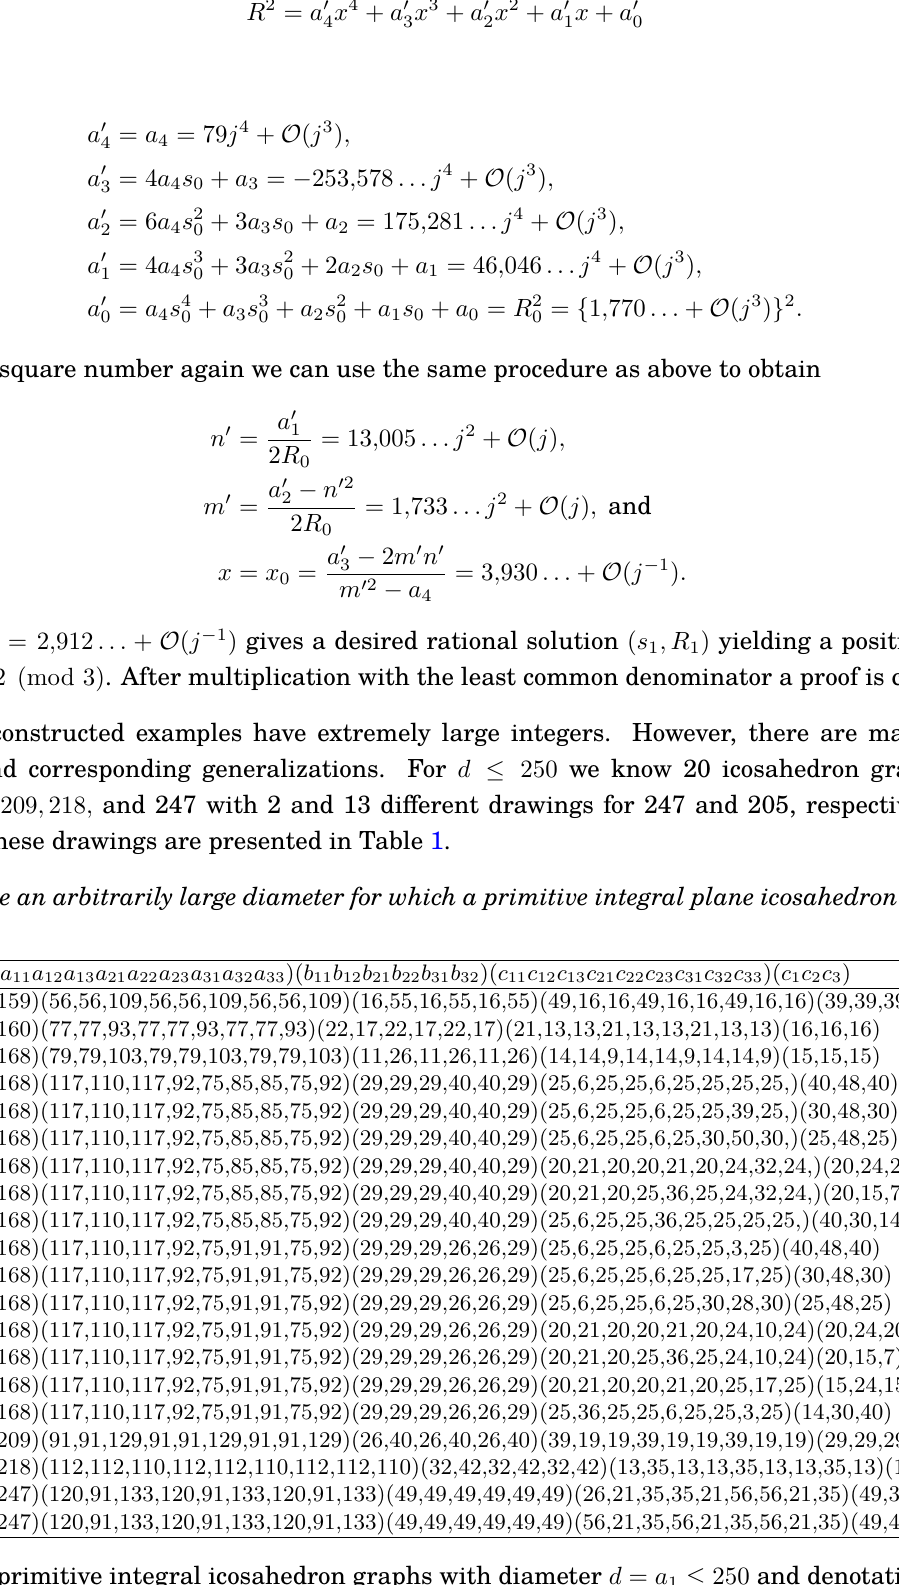
250 and denotation of Figure 11. ≤